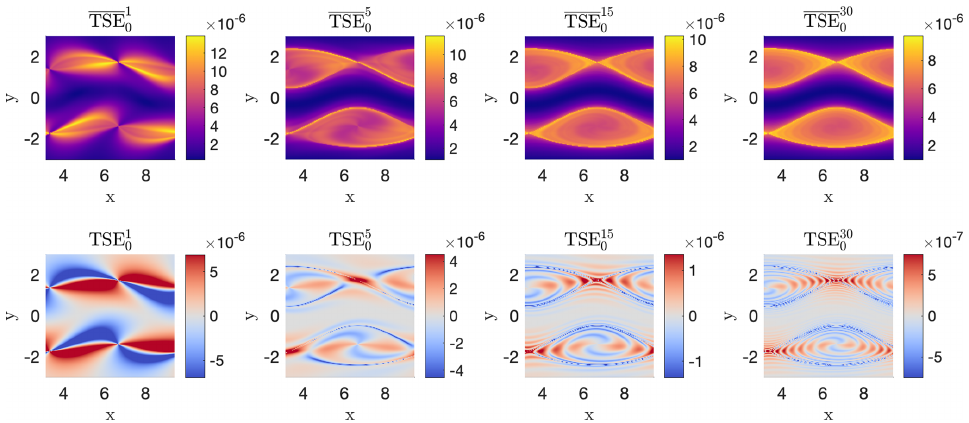
Figure A3. Comparison of TSE and TSE contours for increasing integration times from 1 to 30d (L to R) for a subsection of the Bickley jet. The eddies, saddles between eddies, and central jet are evident for all integration times, but the clarity of boundaries increases as the integration time increases. Note this improvement is not always possible with time-dependent flows as features may change.